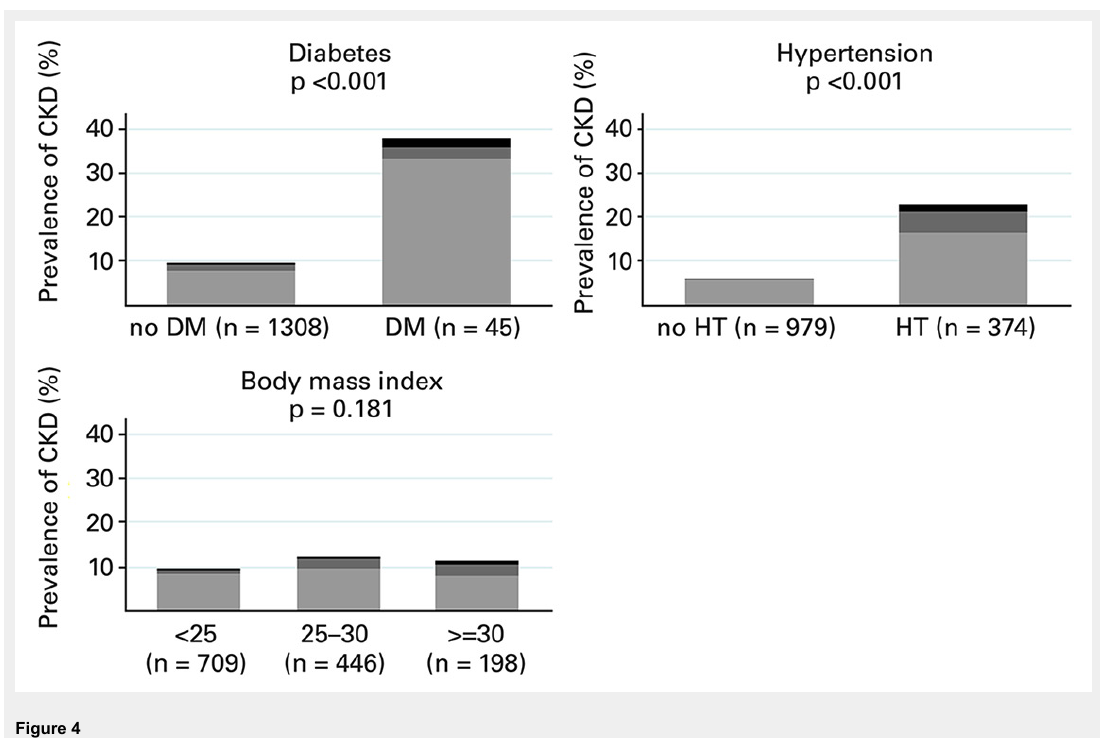
Figure 4 Prevalence of moderate, high and very high risk categories using the CKD KDIGO(2012) classification, by diabetes (panel a), hypertension (panel b), and BMI categories (panel c). CKD = chronic kidney disease; DM = diabetes mellitus; KDIGO = Kidney Disease – Improving Global Outcomes; HT = arterial